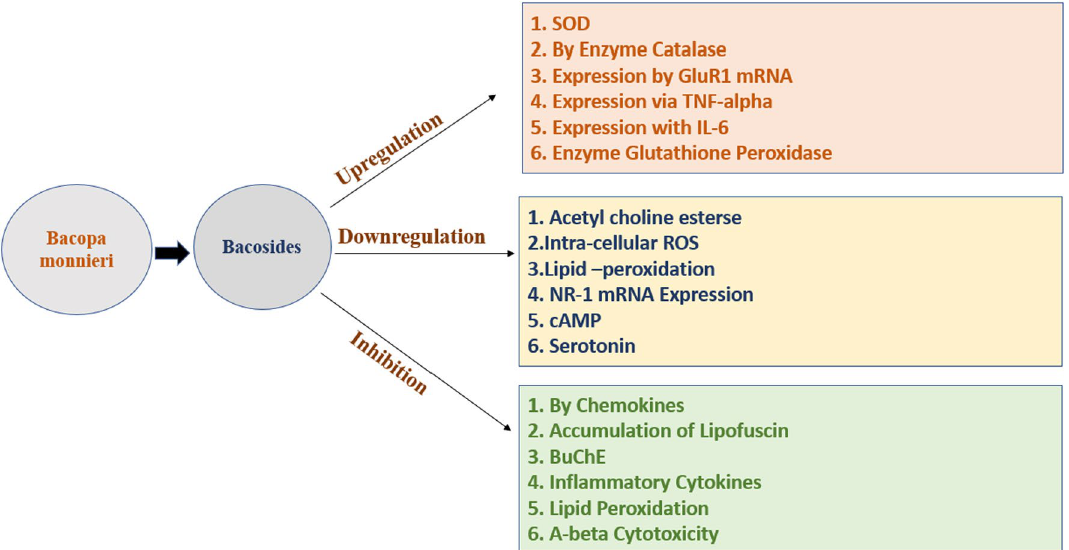
Fig. 4 Various pharmacological mechanisms of bacosides to treat neurodegeneration and neurological